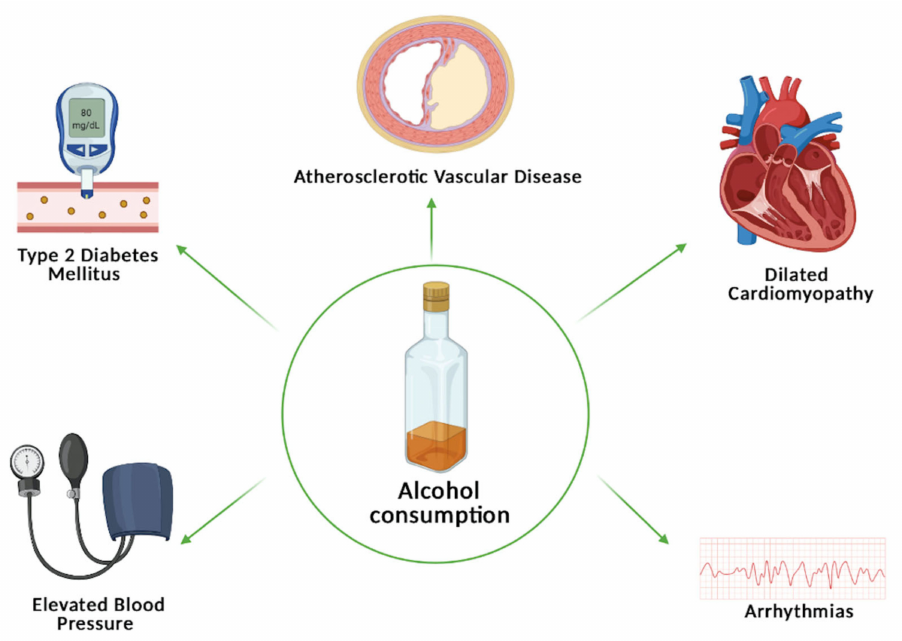
Figure 1. The association between alcohol consumption and arrhythmias, dilated cardiomyopathy, hypertension, atheroscle- rotic vascular disease, and type 2 diabetes